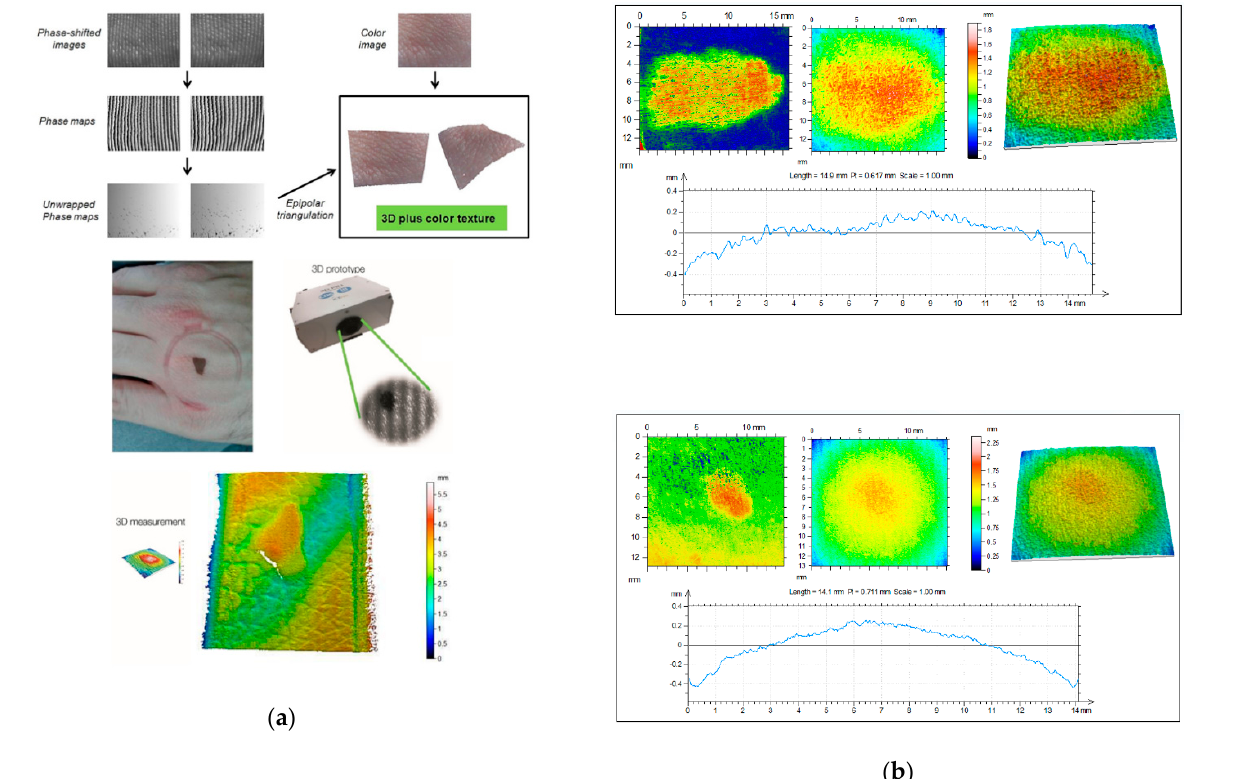
Figure 3. From Rey-Barroso et al. [65], ( a ) 3D fringe projector. The fringe images are reconstructed and unwrapped to obtain 3D images with superimposed color texture. A pigmented lesion and its heights maps are shown below. ( b ) Three-dimensional (3D) topographical images of a melanoma (top) and a nevi (bottom). The melanoma seems to have a rougher